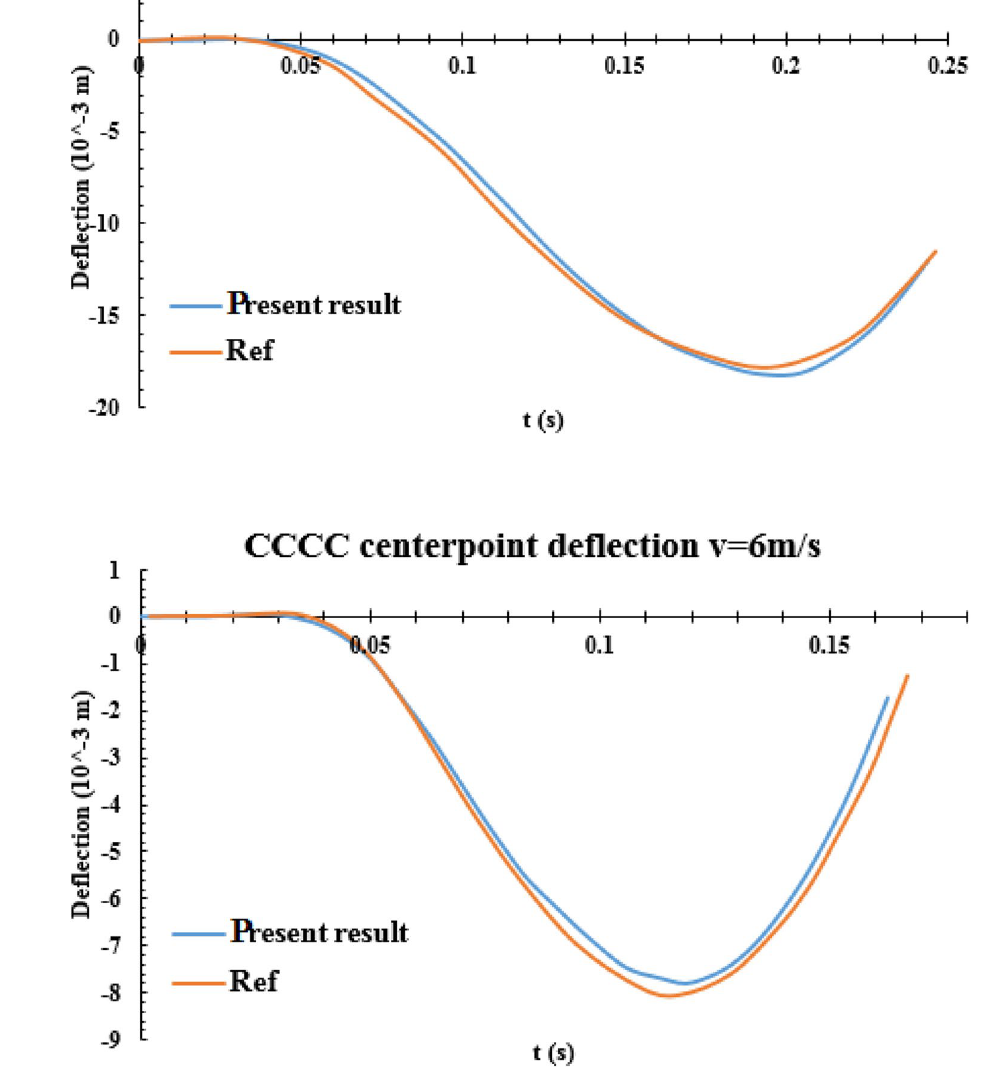
Fig. 3 Nonlinear transient deflection of plate compared with Ref [44] for SSSS bound- ary condition